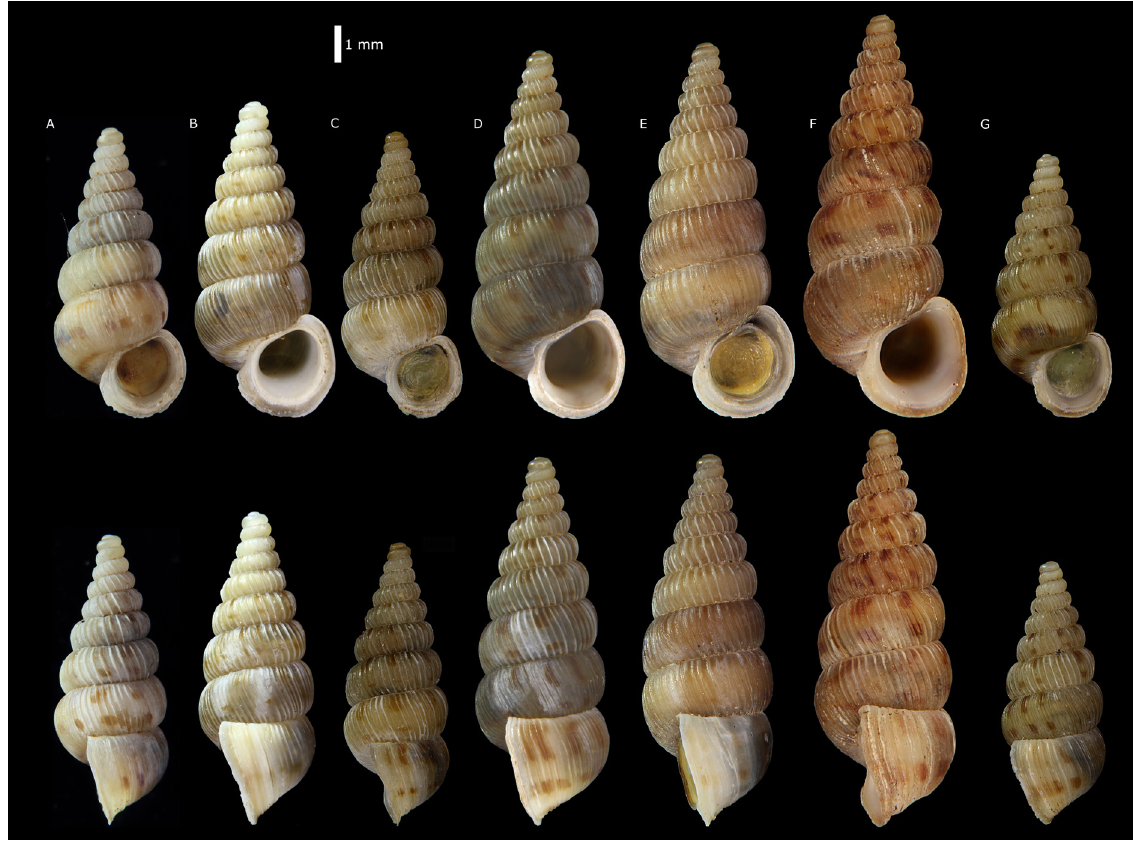
Fig. 17. Shell variability in Cochlostoma ( Clessiniella ) villae (Strobel, 1851). A . Mizzole, Italy (EZ0878). B . Covoli di Velo, Italy (EZ0879). C . Ferrazza, Italy (EZ0881). D . Mt delle Piume, Italy (EZ0889). E . Perarolo, Italy (EZ0891). F . Lumignano, Italy (EZ0893). G . Ca’ Gottolo, Italy